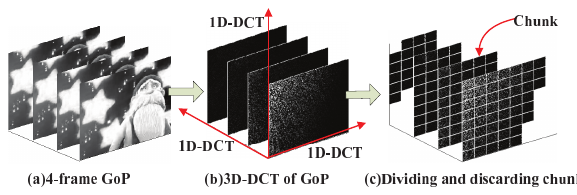
Figure 2: 3D-DCT of a 4-frame